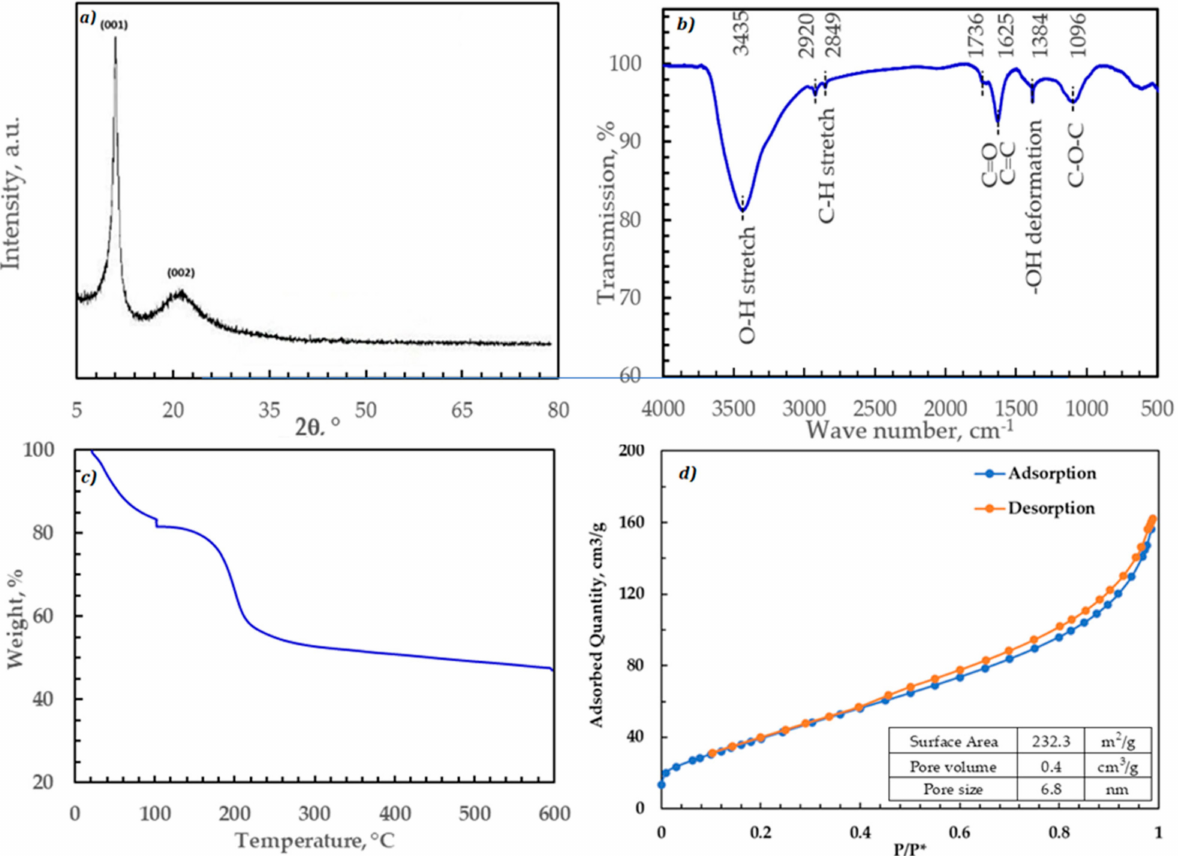
Figure 3. Characterization figures for the GO used in this study: ( a ) XRD X-ray diffraction pattern; ( b ) FTIR analysis; ( c ) TGA thermal stability curve; ( d ) BET nitrogen hysteresis curves for GO at 77